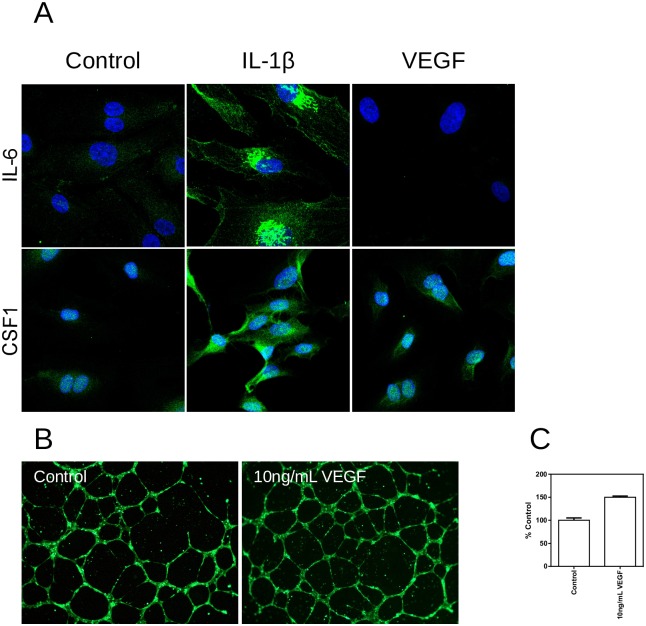
Immunofluorescence and tube formation in untreated HUVEC, HUVEC treated with 10ng/mL. IL-1β and HUVEC treated with 10ng/mL VEGF.(A) Immunofluorescence staining for IL-6 and CSF-1. (B) Calcein stained tubes of HUVEC treated with 10ng/mL VEGF (right) and the untreated control (left). (C) Quantification of tube formation using the angiogenesis plugin of ImageJ. Tube length was determined as pixels per tube, data are expressed as %control.